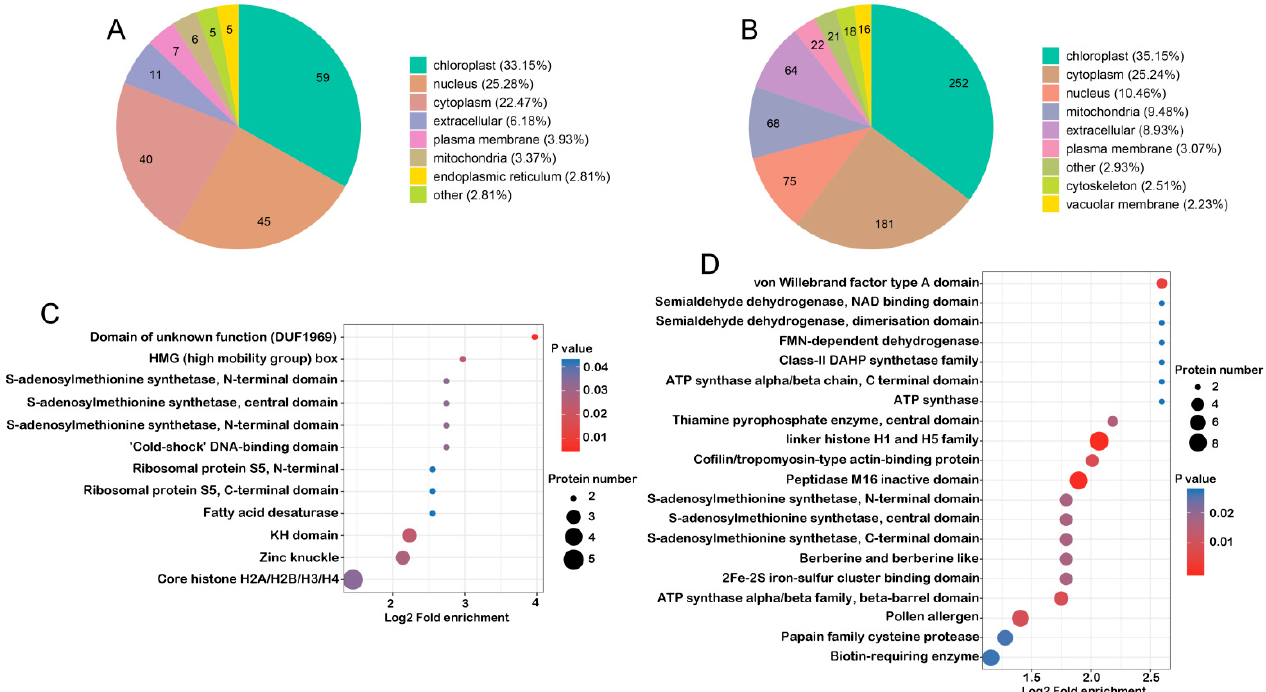
Figure 5. Characteristics of the different comparison groups of anthers. ( A ) Subcellular localization of DEPs in P2 vs. Y2. ( B ) Subcellular localization of DEPs in P4 vs. Y4. ( C ) Enrichment of DEPs domains in P2 vs. Y2. ( D ) Enrichment of DEPs domains in P4 vs. Y4.